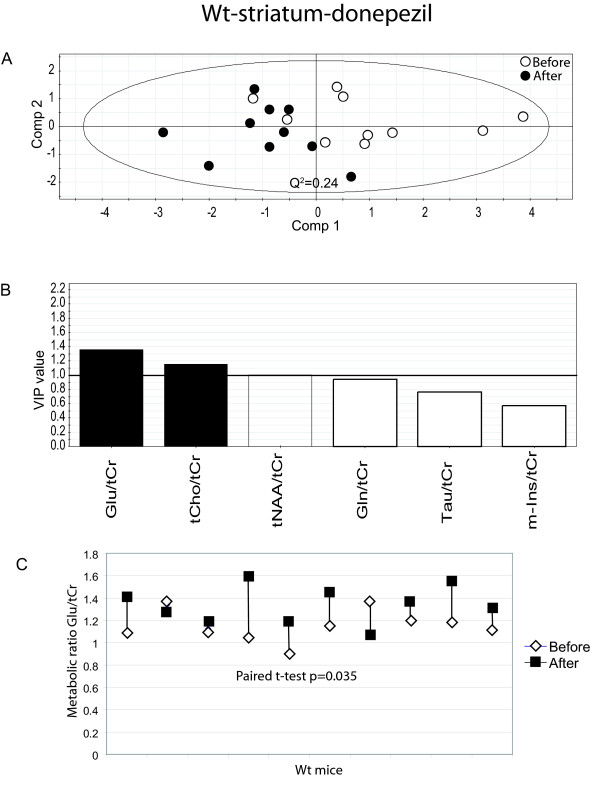
Results from the data analysis of donepezil treated wild type mice (striatum). (A) PLS-DA scatter plot which displays a clear separation between mice before and after donepezil treatment (white circles = before treatment and black circles after treatment). Each data point represents one mouse. A Q2-value above 0.05 indicates that the groups can be significantly distinguished along that component. (B) Metabolites which are important for the separation between groups in the PLS-DA model. VIP (variable of importance in the projection) values larger than 1 are relevant in explaining group differences (black bars) while metabolites with values below 1 have no significant impact (white bars). (C) The paired t-test shows a significant increase in Glu, p = 0.035. White diamonds represent before treatment and black squares after treatment.